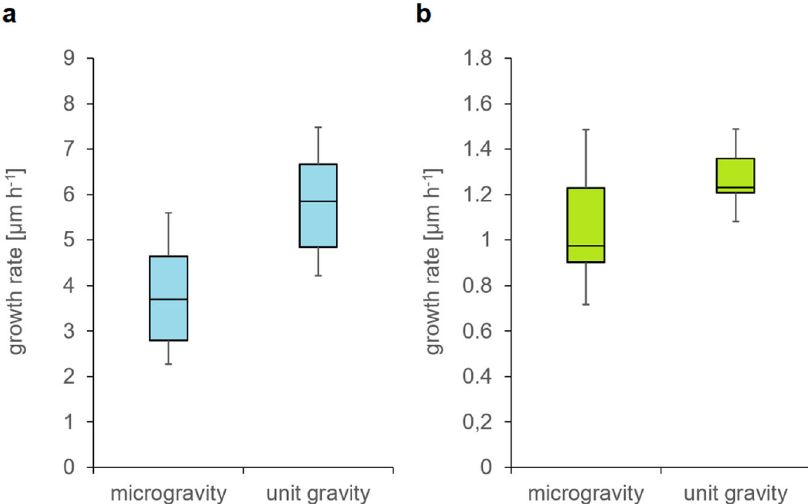
Fig. 4 Comparison of the growth rates. a Growth rates are shown for lysozyme and b for Pf GST crystals at unit gravity and under microgravity conditions for the time frame from 5 to 147 h after thawing. For both conditions 17 crystals from the same corresponding capillary section were